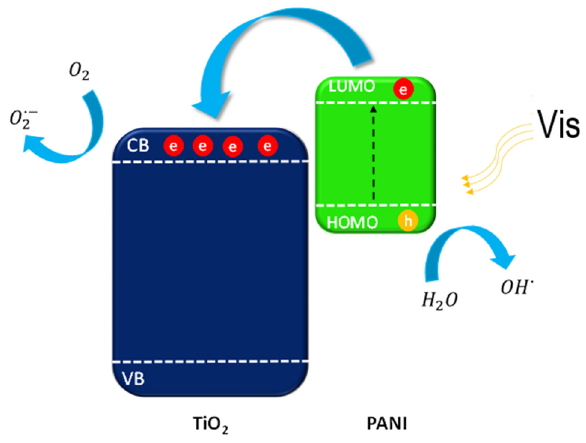
Figure 14. Mechanism of PANI–TiO 2 nanocomposite excitation under visible light.